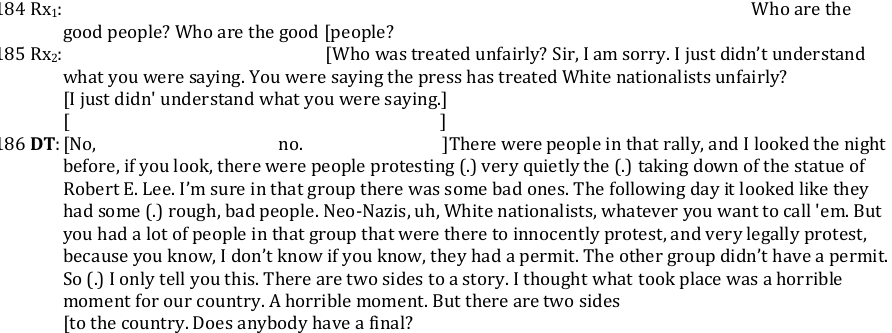
Figure 17. Transcript excerpt 184–186.